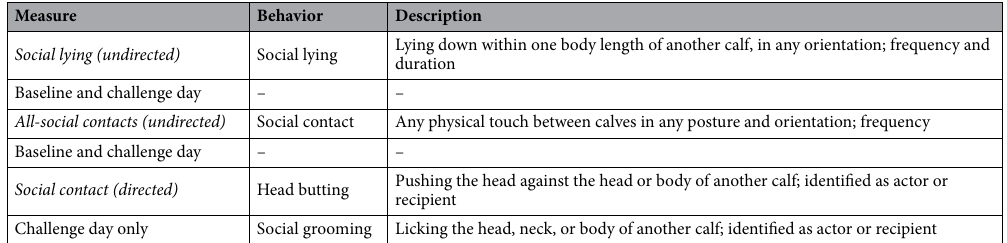
Table 1. Ethogram used to describe behaviors of calves (35.9 ± 8.8 days of age) housed in groups (6 calves/ pen) exposed to either an experimental challenge model (inoculation with M. haemolytica ) or a control (inoculation with sterile